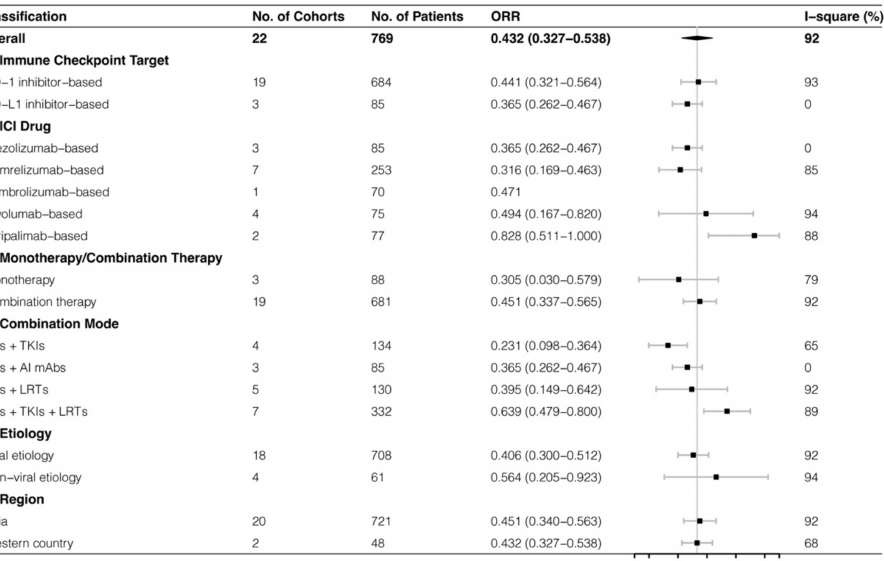
Figure 4. Subgroup analysis of ORR judged by mRECIST